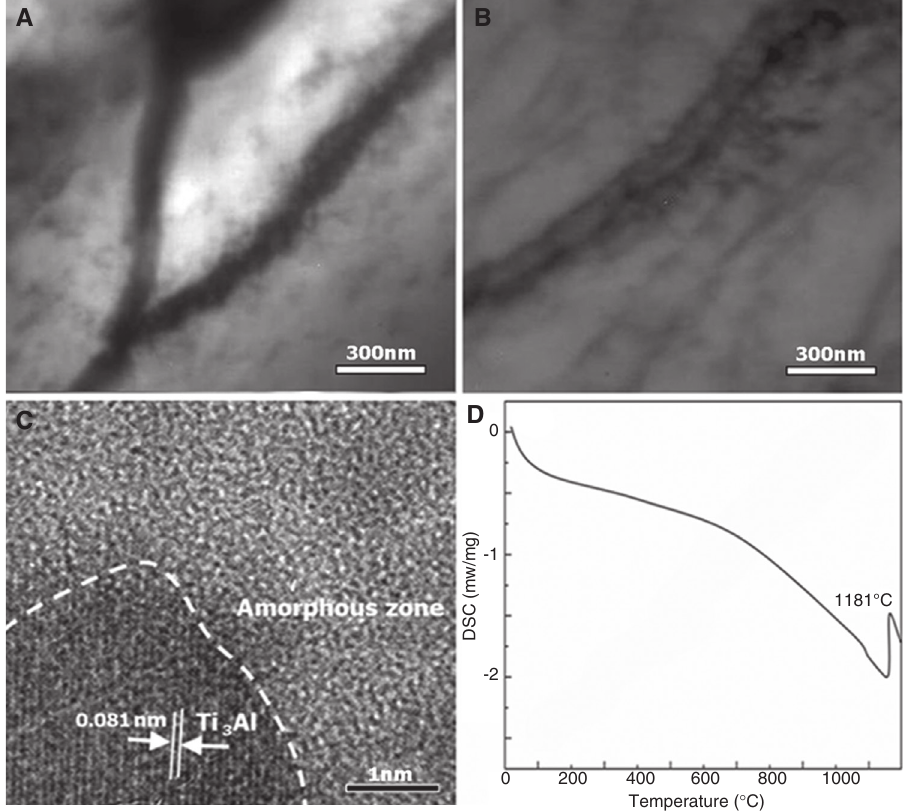
Figure 4 TEM morphologies of the micro-crack (A) and stress fringes (B), HREM morphologies of the coating (C), and DSC curve of alloying powder